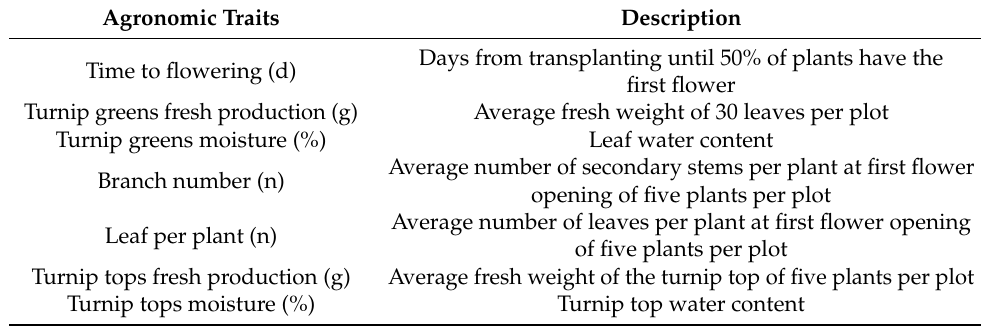
Table 2. Agronomic traits used in the evaluation of varieties of Brassica rapa from northwestern Spain and South Italy. Agronomic Traits Description Days from transplanting until 50% of plants have the Time to flowering (d) first